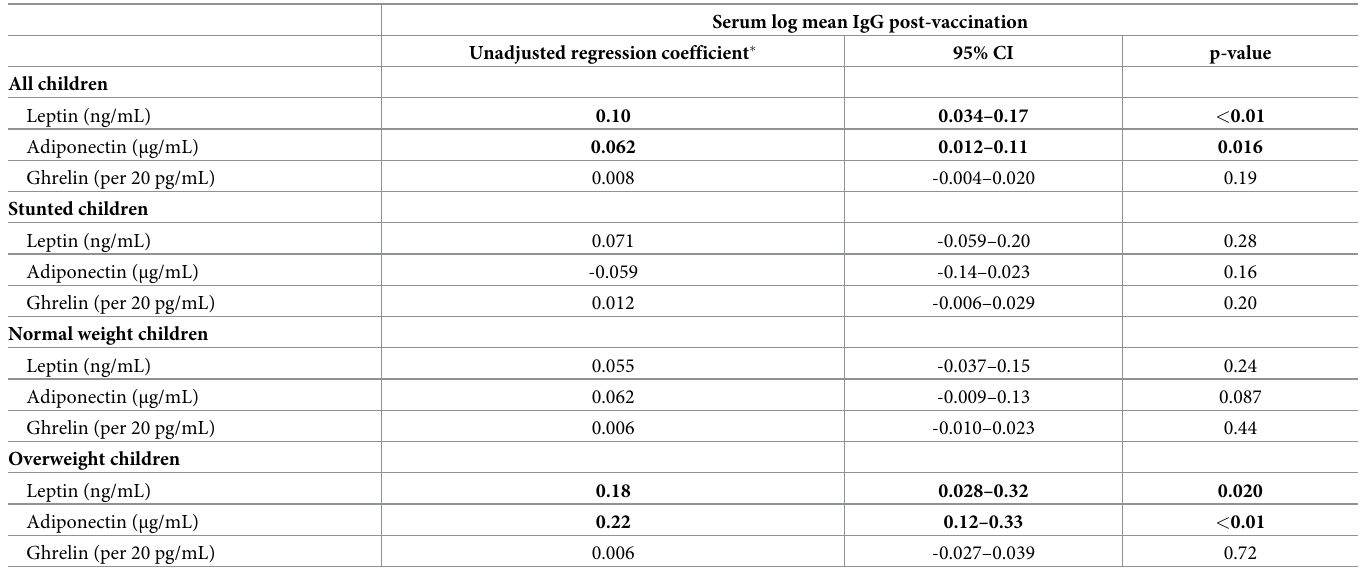
overweight was significantly positively associated with post-vaccination antibody levels in mul- tivariable analysis (regression coefficient 0.14, 95% CI 0.049–0.22). Hence, an increase in adi- ponectin levels in stunted children is associated with lower PCV antibody levels while an increase in adiponectin levels in overweight children is associated with higher PCV antibody levels (Fig 2A, Table 3). Further, we observed a borderline significant association between ghrelin levels and post-vaccination antibody levels in overweight children (regression coeffi- cient 0.009, p = 0.02) (Table 3). No significant association of leptin with PCV13 response was observed in multivariable analysis.